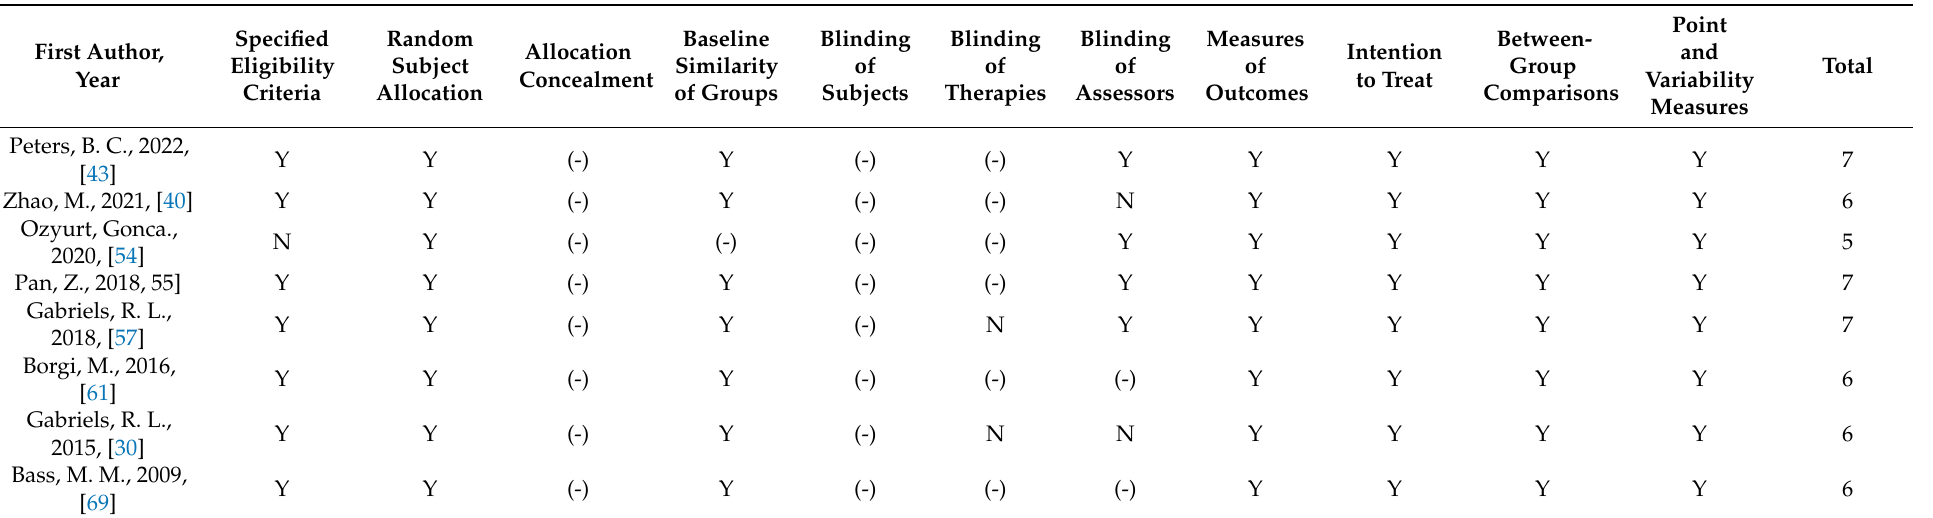
Table 4. PEDro scoring for